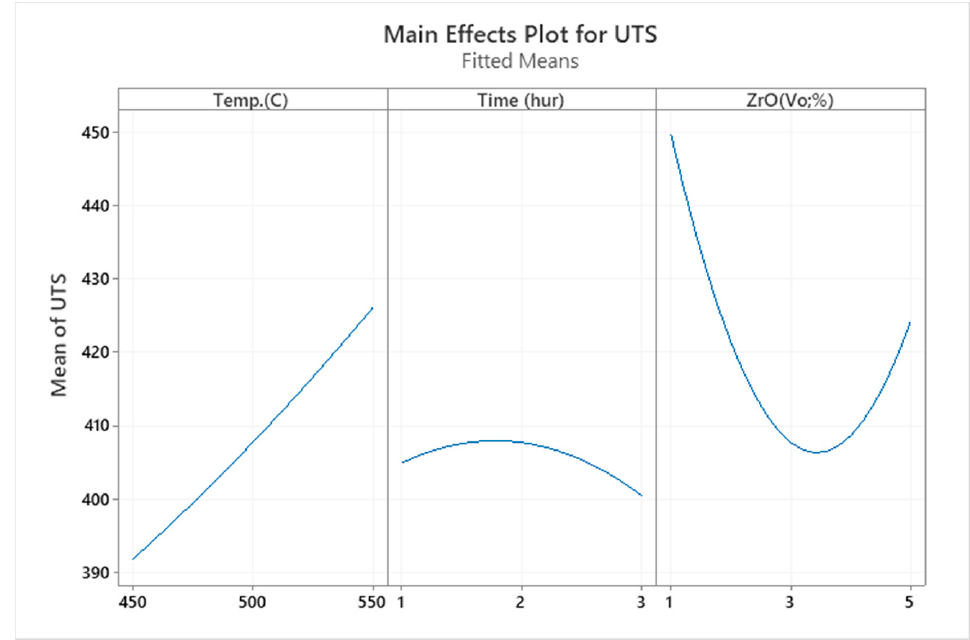
Figure 7. The main effect plot for UTS.